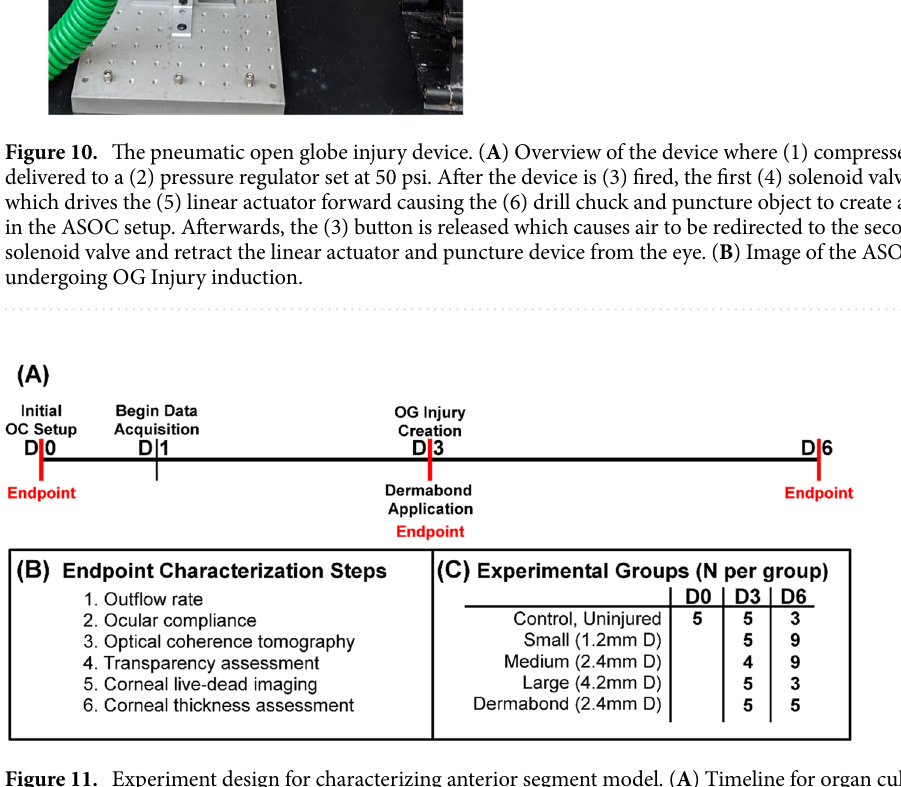
Figure 11. Experiment design for characterizing anterior segment model. ( A ) Timeline for organ culture studies, showing initial setup at D0, initializing data acquisition on D1, creating OG injures on D3, and tracking injury progression out to D6. Endpoint times are indicated in red. ( B ) Overview of the endpoint characterization steps used in this study. ( C ) 11 total experimental groups evaluated in this study which span three time points and 5 experimental conditions. Sample sizes are indicated for the number of ASOC experiments which had IOP values in the acceptable 5 to 20 mmHg IOP range for each